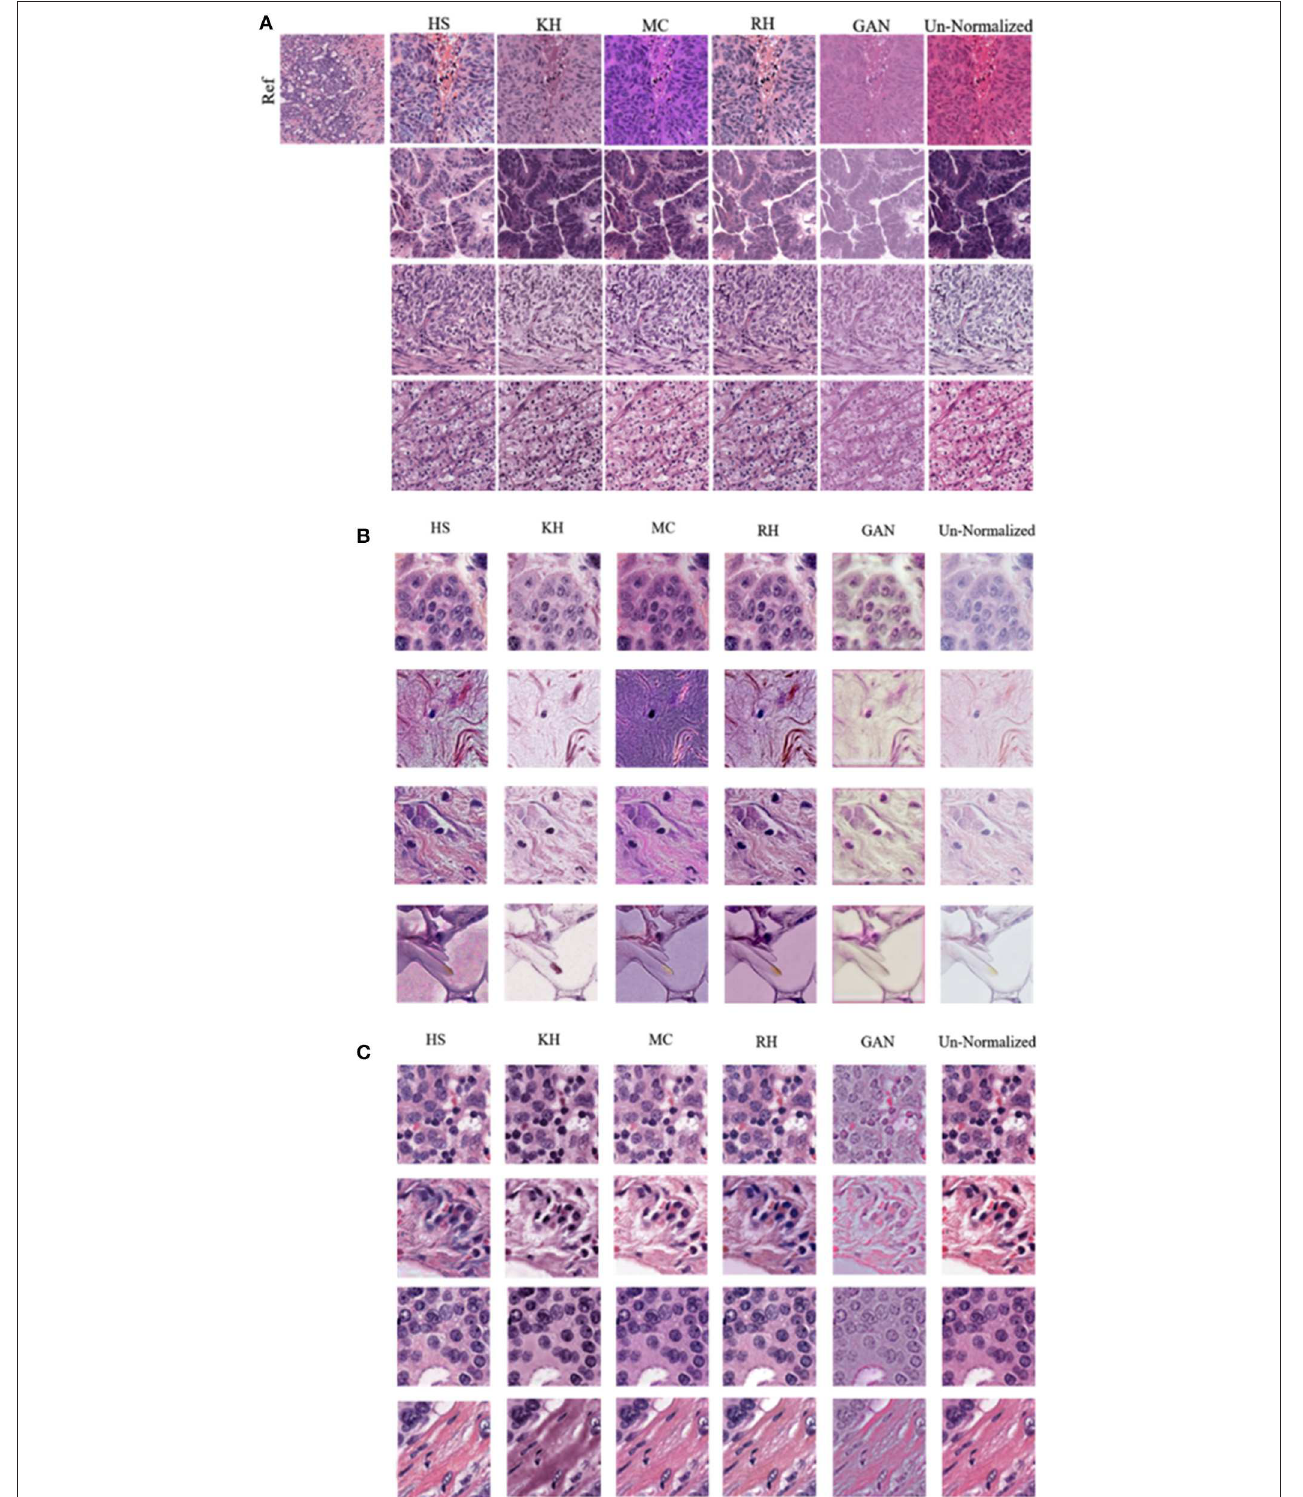
FIGURE 6 | Comparison of various color normalization methods. (A) TCGA-Kumar dataset (B) TNBC dataset and (C) SMH-seg dataset. First column represents the reference image, while the following columns represent the color normalization methods, with the last column as the un-normalized query image.